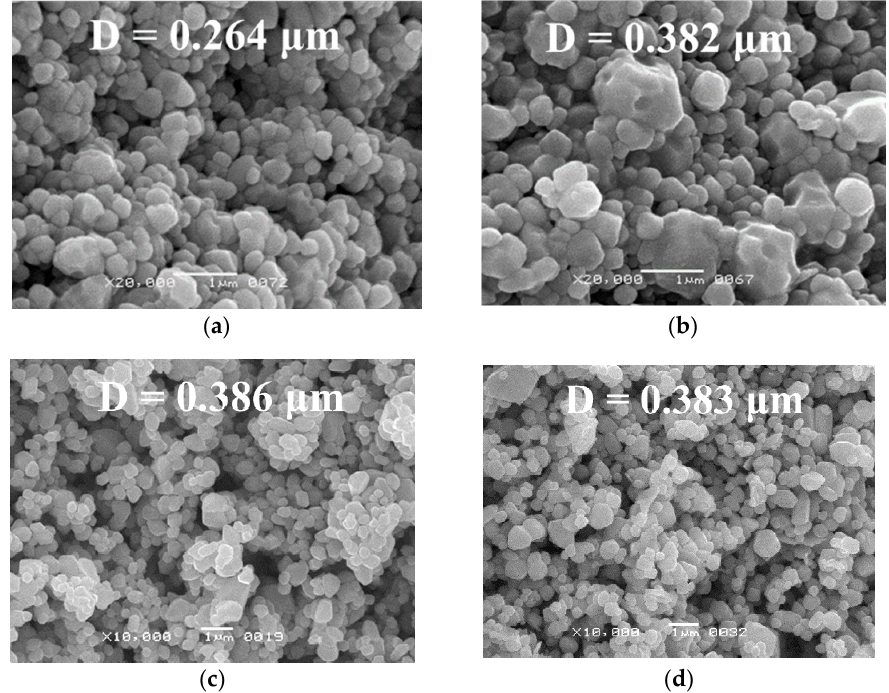
Figure 5. Microstructure of CSP and TVT samples, additive-ammonium chloride: ( a ) CSP3 sample (4.56 mol% NH 4 Cl); ( b ) CSP4 sample (7.6 mol% NH 4 Cl); ( c ) TVT3 sample (4.56 mol% NH 4 Cl); ( d ) TVT4 sample (7.6 mol% NH 4 Cl).